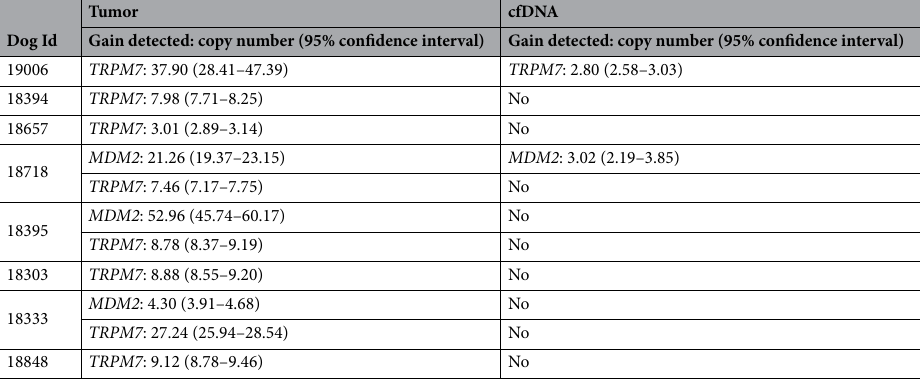
Table 1. Results of the ddPCR assay to identify the CNA of the TRPM7 and MDM2 genes in tumors and plasma of dogs with OMM. Eight dogs had at least one gene amplified in their tumors, and two dogs had a copy number imbalance in the